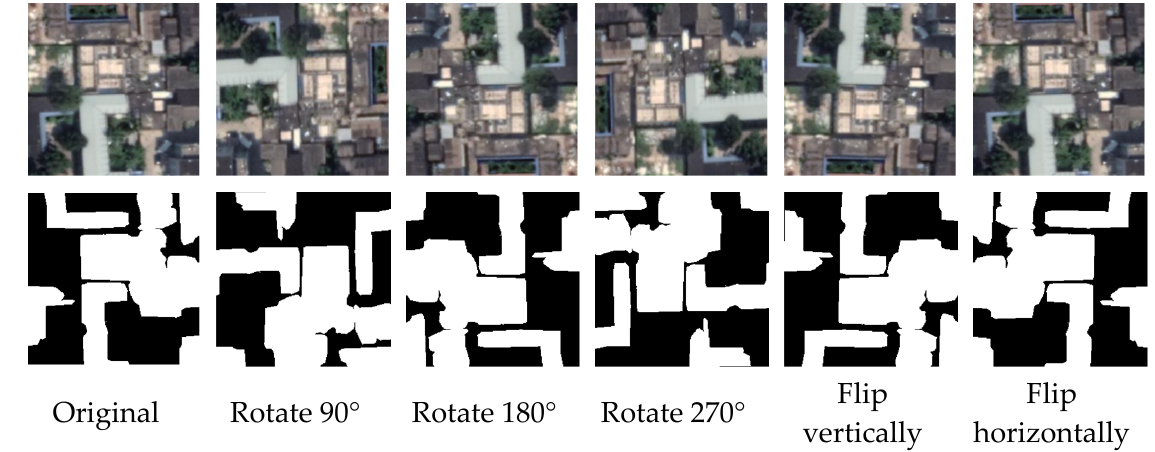
Figure 10. An example of data augmentation by rotating and flipping.